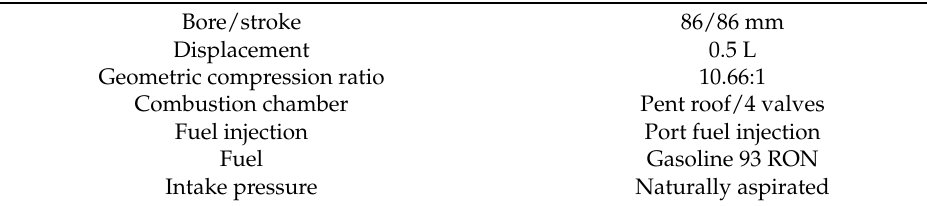
Table 1. Engine specifications.